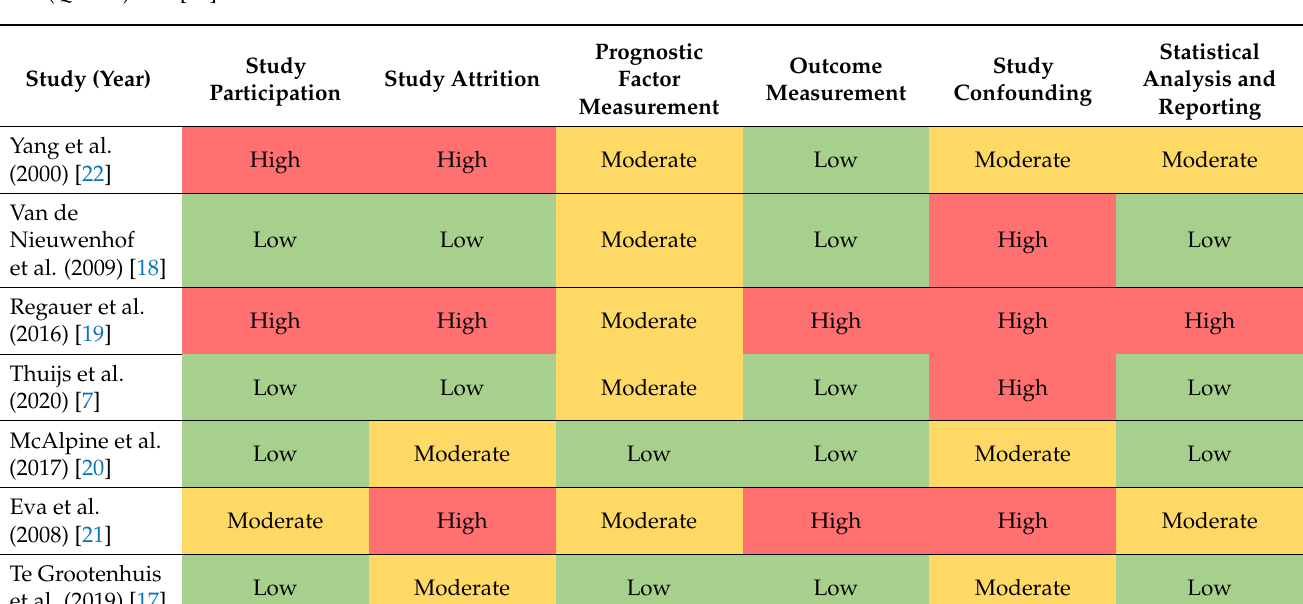
Table 2. Risk of bias summary: judgement of each domain for all included studies using the Quality of Prognostic Studies (QUIPS) tool